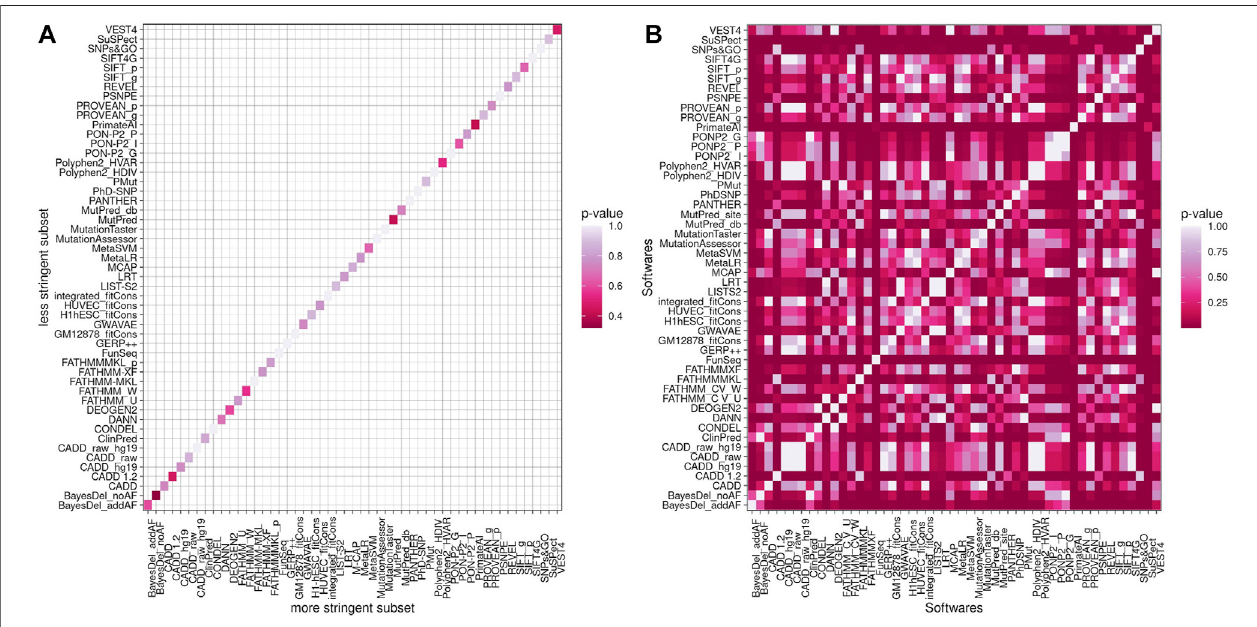
FIGURE 4 | p -Value of Fisher ’ s exact test comparing less stringent criteria and more stringent criteria (A) and the 51 estimates in a less stringent subset (B) .